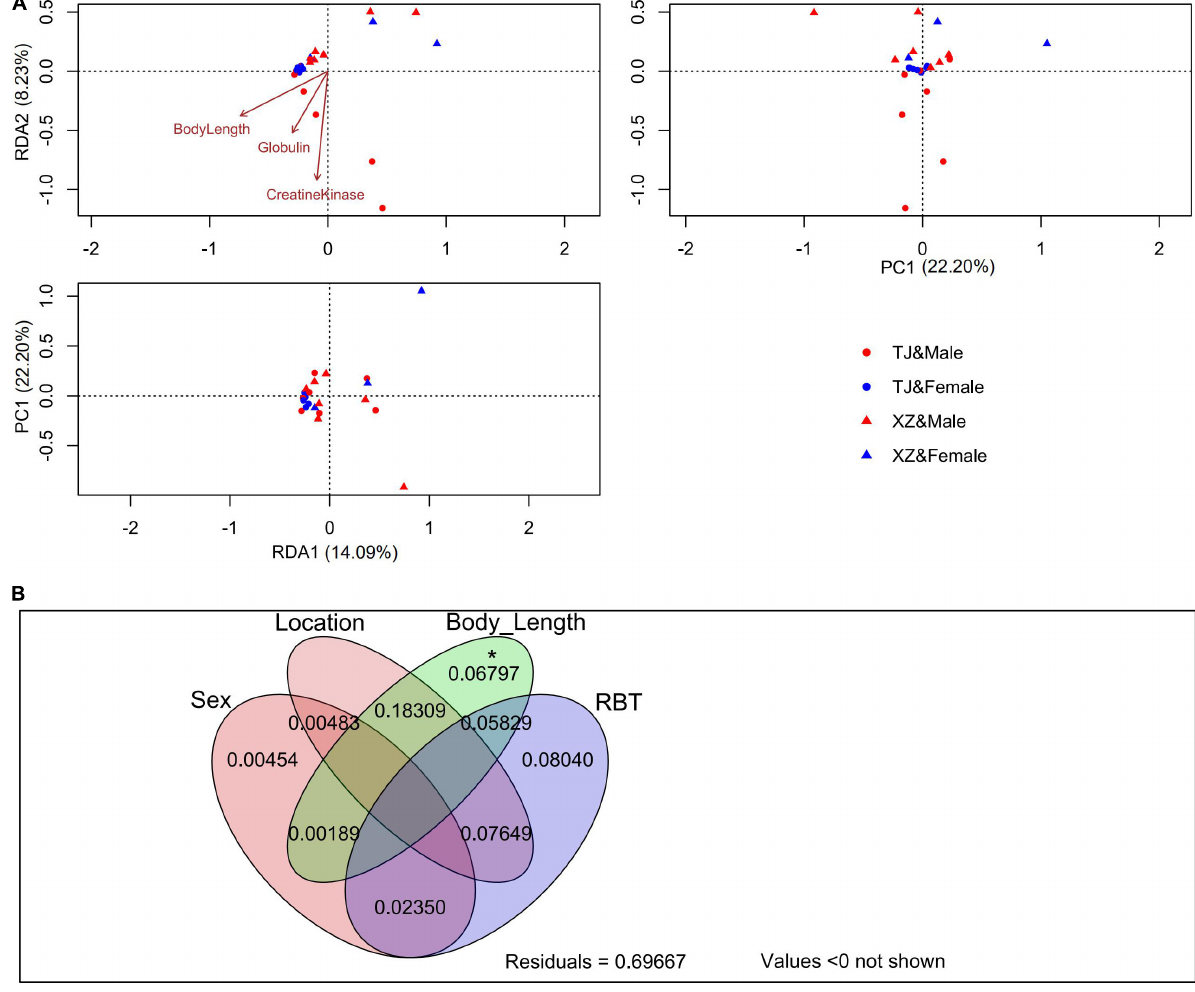
FIGURE 2 | RDA (A) and VPA (B) on the rarefied OTU table with Hellinger transformation. The significance of each explained variation was tested by the permutation test under the reduced model (permutation number = 999). * p <